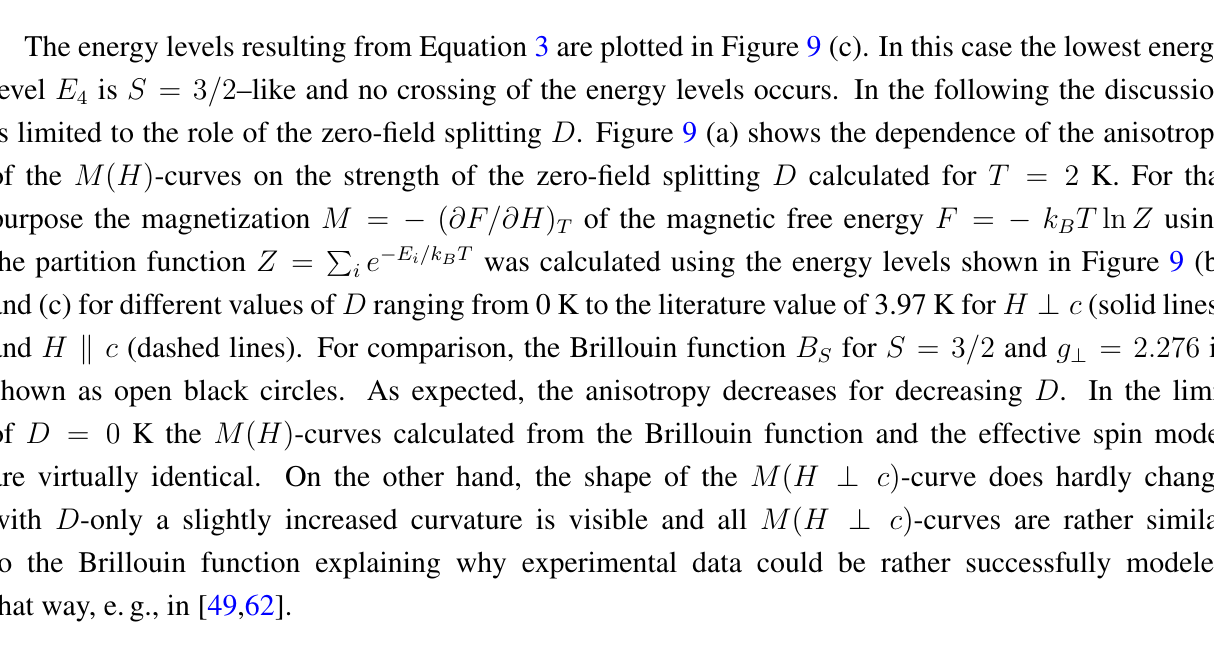
Figure 9. (a) Calculated M ( H ) -curves at 2 K for H ∥ c (dashed lines) and H ⊥ c (solid lines) using the effective spin model and different values of the zero field splitting D . The Brillouin function is given for comparison (open circles) as well as experimental SQUID data of the PM-RMS sample (blue triangles). The M ( H ) -curves were derived from the calculated energy levels for H ∥ c (b) and H ⊥ c (c) using literature